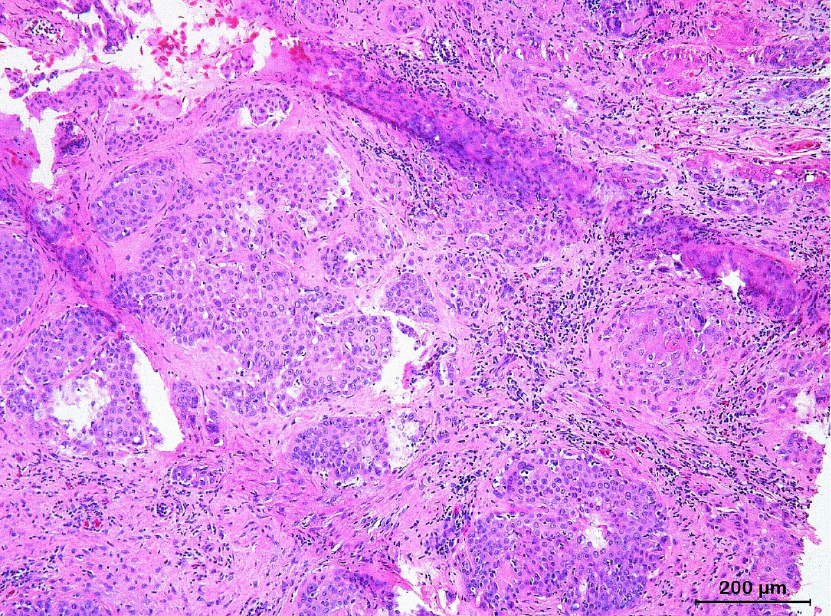
Figure 3. Histological section of a moderately differentiated squamous cell carcinoma from the oral mucosa of an African spurred tortoise ( Centrochelys sulcata ) showing tumor cells containing scant eosinophilic cytoplasm, haphazard squamous differentiation and marked nuclear atypia. Animals 2023 , 13 , x FOR PEER REVIEW Six SCCs could be unambiguously classi fi ed as KAs and were exclusively diagnosed in lizards. They presented as an exo–endophytic, cyst-like epidermal proliferation that creates a crateriform lesion with a central keratinous plug (Figure 4). Areas of pseudoepi- theliomatous hyperplasia with minimally in fi ltrating well-di ff erentiated squamous cells formed folds inside the crater and the adjacent dermis. Mild nuclear atypia and a low mitotic index were invariably present.